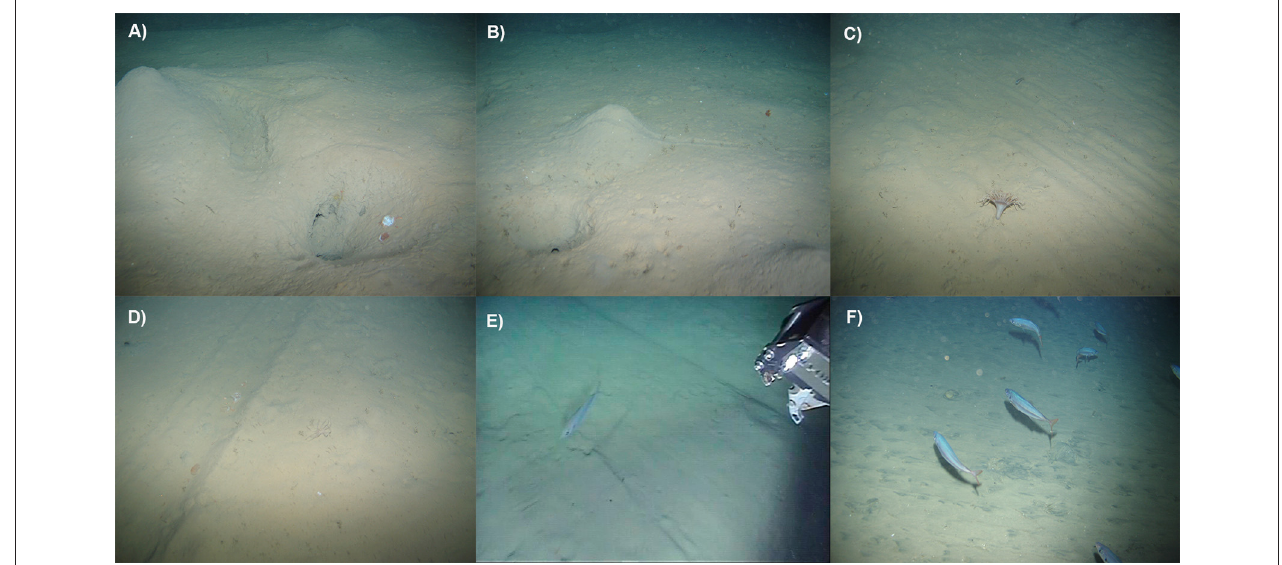
FIGURE 3 | Seabed image samples from the study area within muddy-sand sediments (A6.4). (A,B) Undisturbed locations at the Setúbal area (NT) showed heterogeneous topography and large faunal activity (e.g., tracks, burrows, and mounds of various sizes). Older evidence of trawling disturbance was demonstrated by the (C) chain/nets scars and (D) trawl doors marks with clear signs of bioturbation activity. Recent passages by trawlers were evidenced by (E) large door marks and (F) adjacent locations with flattened seabed surface with no recent faunal activity evidence. Photo credits: VLIZ and UGent.